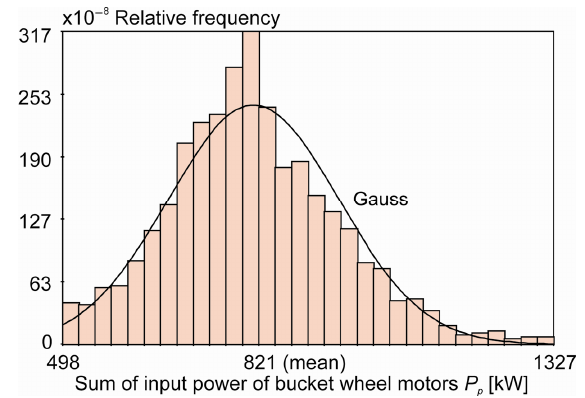
Fig. 5. Averaged revolutions of bucket wheel motors vs. mining time